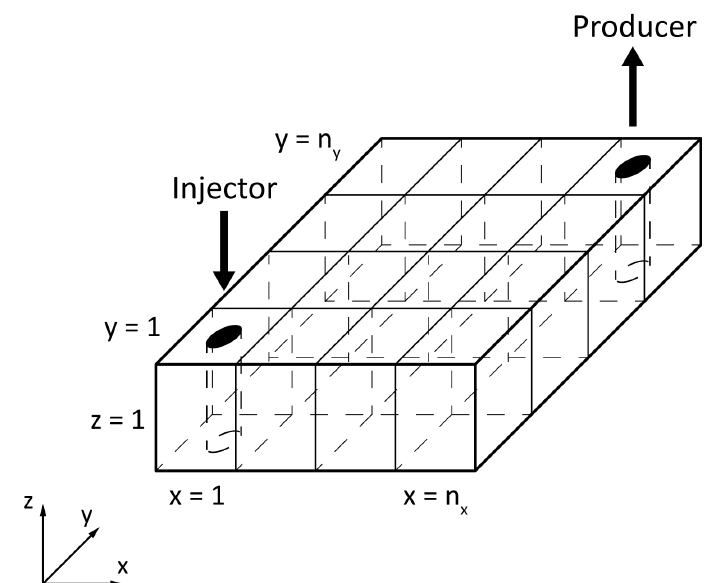
Figure 1. Schematic representation of the quarter 5-spot oilfield used for the EOR simulations